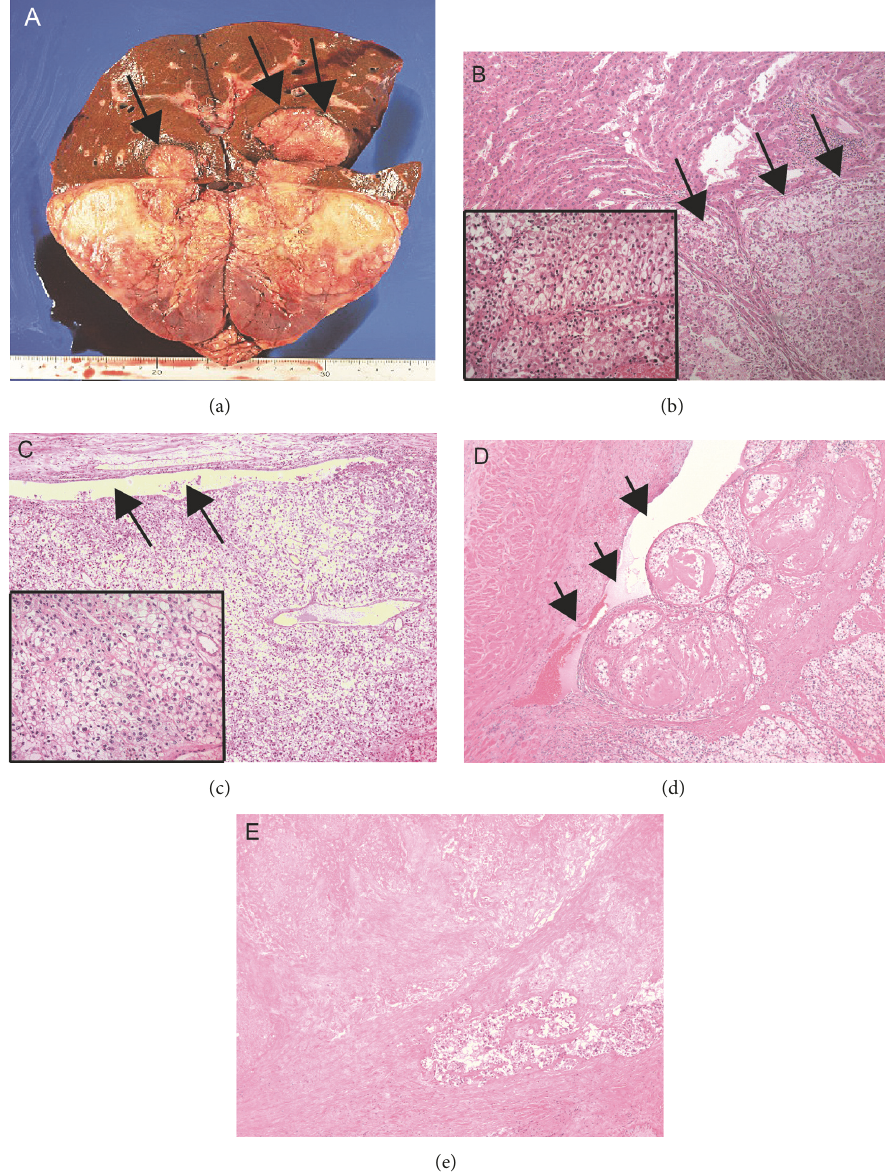
Figure 4: Macroscopic appearance (a) and pathological findings (b-e) of resected specimen . Renal tumor directly invading the right lobe of the liver (arrows, (a)). Tumor cells showing clear cytoplasm with atypical nuclei infiltrated into the liver parenchyma ((b) invasion front is shown by arrows). Pathological appearance of tumor cells at invasion front is compatible with conventionally clear cell-type renal cell carcinoma (inset, high magnification). The primary tumor also shows similar pathological findings ((c) arrows show renal pelvis, inset: high magnification). Infiltration to large vessel ((d) arrows) and large amount of necrotic area (e) are